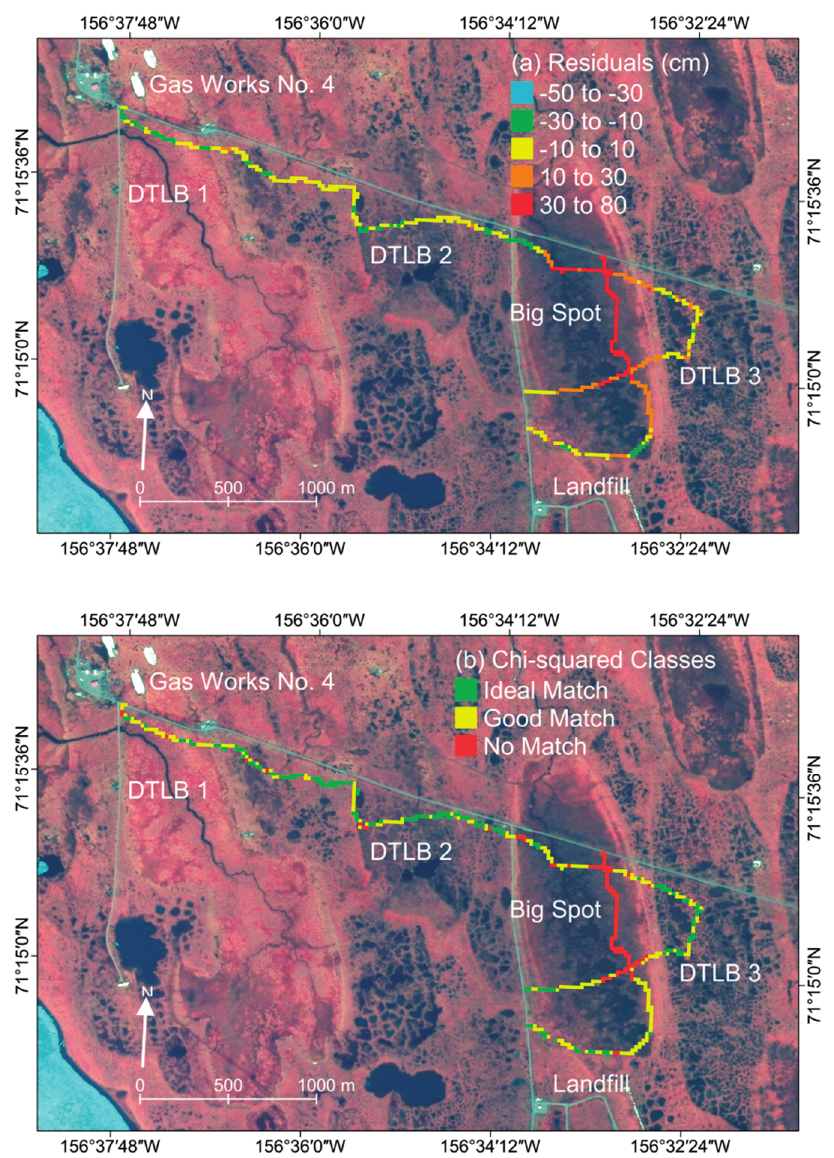
Figure 6. Residuals ( a ) and χ 2 classes ( b ) between the GPR ALT and ReSALT at Big Spot. The Big Spot site consisted of a series of drained thermokarst lake basins (DTLB) with Big Spot drained thermokarst lake basin (DTLB) itself showing the largest ReSALT values in the entire